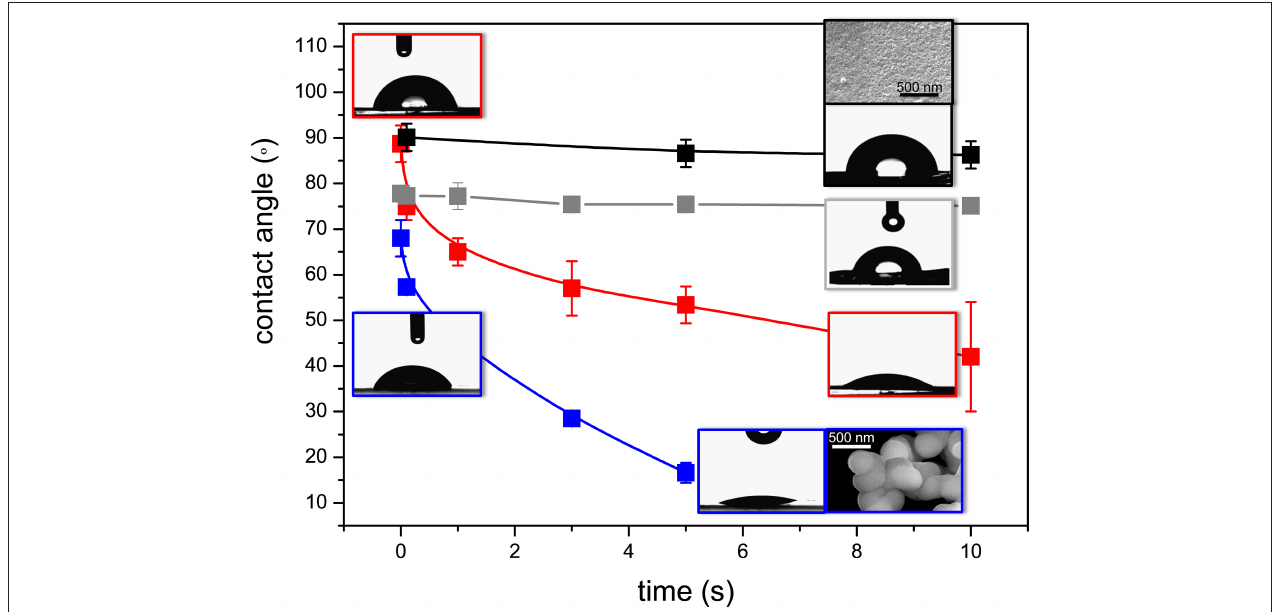
FIGURE 7 | Time-dependence of the contact angle of the BS-1 (black line), BS-2 (gray line), BS-3 (red line), and BS-4 (blue line) hybrids. Insets: HR-SEM images of BS-1 and BS-4.